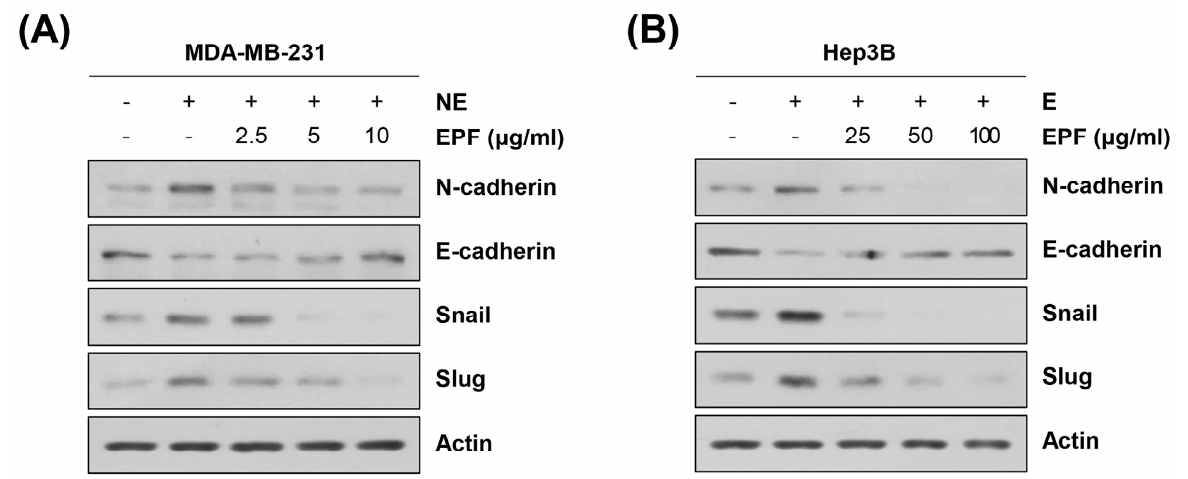
Figure 7. EPF suppresses E/NE-induced EMT in cancer cells. ( A , B ) MDA-MB-231 human breast cancer cells ( A ) and Hep3B human hepatocellular carcinoma cells ( B ) were pretreated with EPF at diverse concentrations (2.5–10 μ g/mL for MDA-MB-231; 25–100 μ g/mL for Hep3B) for 12 h. Cells were then treated with NE (1 μ M) or E (10 μ M) and incubated for a further 12 h. Expression levels of EMT marker proteins and related transcription factors were determined by Western blot analy-